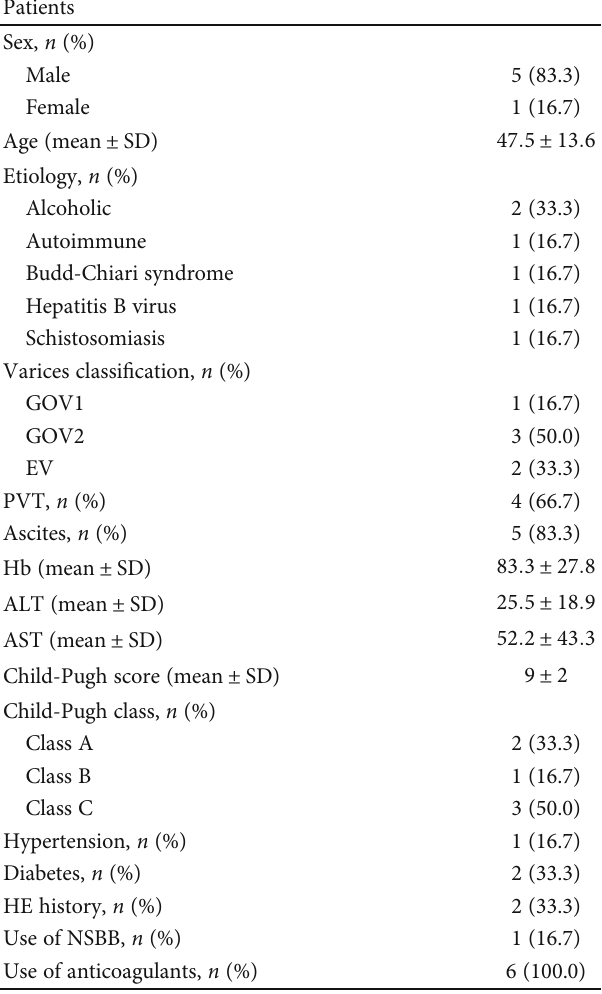
Table 1: Baseline characteristics of the